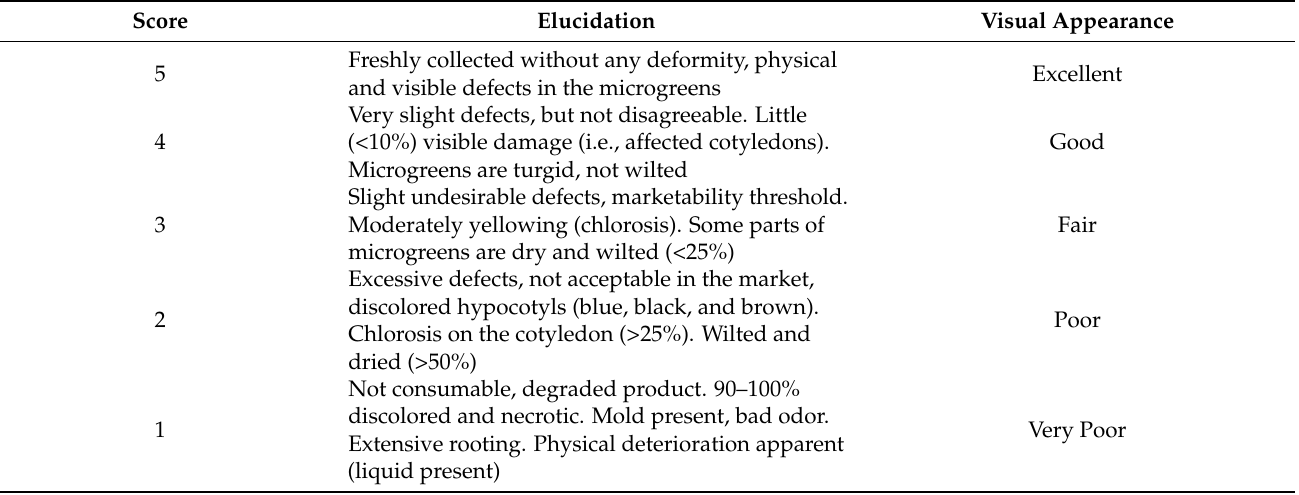
Table 3. Visual quality rating index of